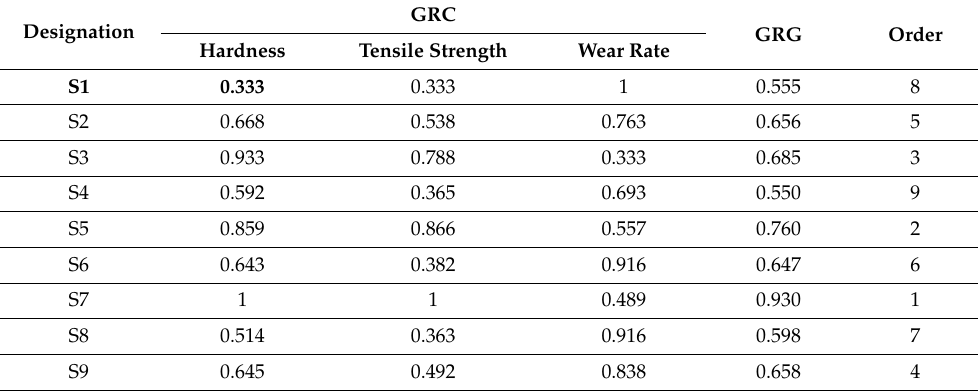
Table 13. GRG and their order.